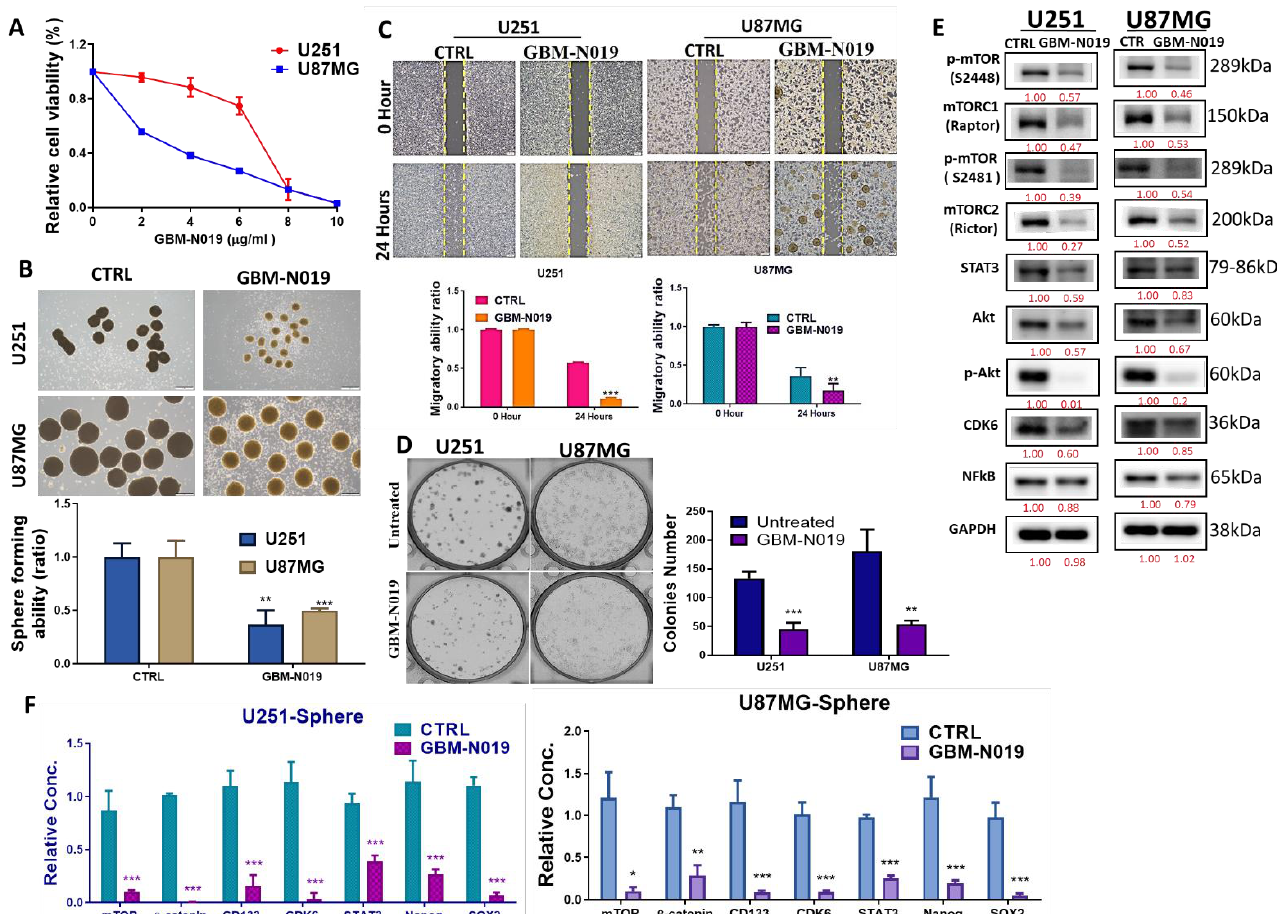
Figure 4. GBM-N019 treatment inhibited tumorigenic properties via downregulating mTOR, STAT3, and CDK6 signaling pathways in vitro ( A ) GBM-N019 treatment significantly hampered the viability of U251 and U87MG cells in dose-dependent manners. GBM-N019 treatment significantly reduced the tumorsphere forming abilities ( B ), migratory ability ( C ), and colony forming ( D ) abilities of both U251 and U87MG cells. ( E ) Western blots of GBM-N019-treated U251 and U87MG cells exhibited lower expression levels of -mTOR, mTORC1, mTORC2, STAT3, Akt, p-Akt, CDK6, and NF-κB. ( F ) qPCR analysis showed decreased gene expression levels of mTOR, β-catenin, CD133, CDK6, STAT3, Nanog, and SOX2 in both U251 and U87MG cells after treatment with GBM-N019. * p < 0.05, ** p < 0.01, *** p < 0.001.